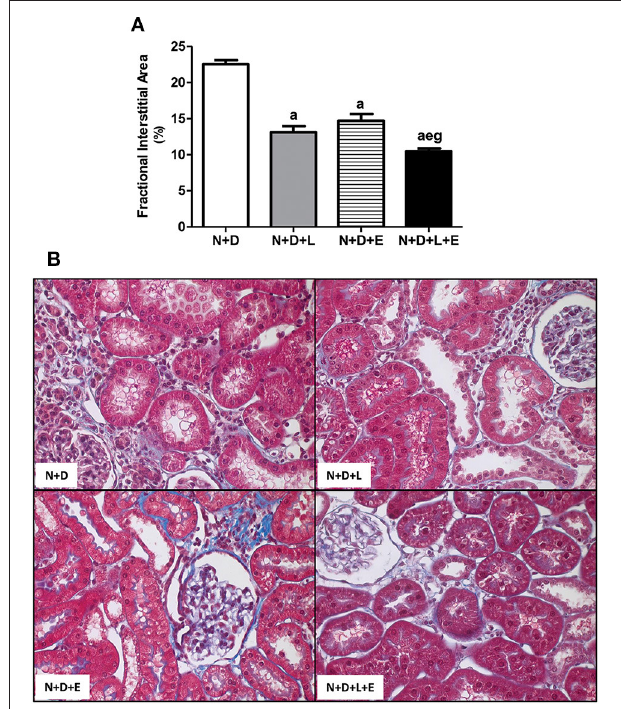
FIGURE 1 | Fractional interstitial area (FIA) in the renal cortex. (A) Bar graph of FIA volumes evaluated 60 days after 5/6 nephrectomy in vitamin D-deficient rats treated with losartan, erlotinib or losartan + erlotinib. (B) Representative photomicrographs of the renal cortex from a N + D, N + D + L, N + D + E, and N + D + L + E rat (x400). Note that the FIA is significantly smaller in the N + D + L + E than in the other groups. Data are mean ± SEM. a p < 0.001 vs. N + D; e p < 0.01 vs. N + D + L; g p < 0.001 vs. N + D + E. N, 5/6-nephrectomized rats; D, vitamin D-deficient rats; L, losartan-treated rats; E, erlotinib-treated rats; L + E, rats concomitantly treated with losartan + erlotinib. N + D ( n = 10); N + D + L ( n = 8); N + D + E ( n = 7); N + D + L + E ( n =